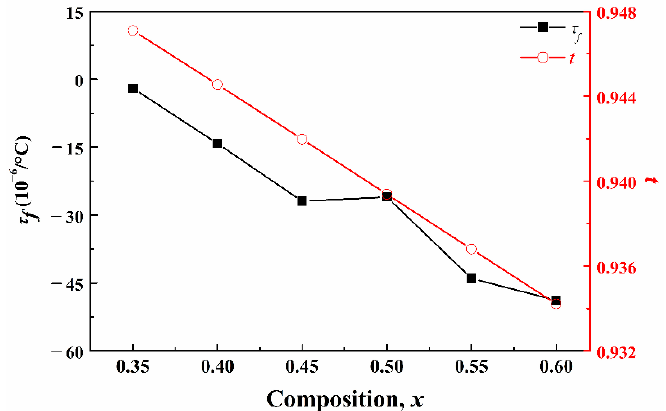
Figure 8. τ f and t of the (1– x )CLT- x NMT ceramics.